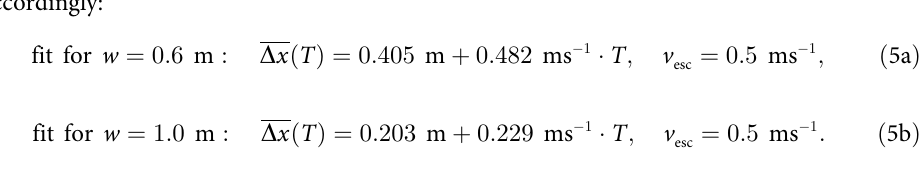
Fig 6. Minimum spatial separations in movement direction depending on the escalator speed (left) and the model parameter T (right). The simulation results are obtained by measuring D x for the escalator widths w = 0.6 m and w = 1.0 m, respectively. Model parameters are fixed by T = 0.25s (left) and v esc = 0.5 ms − 1 (right). The approximations follow from Eq (6) using d step = 0.4 m, O shaded area indicates the range of typical escalator speeds.